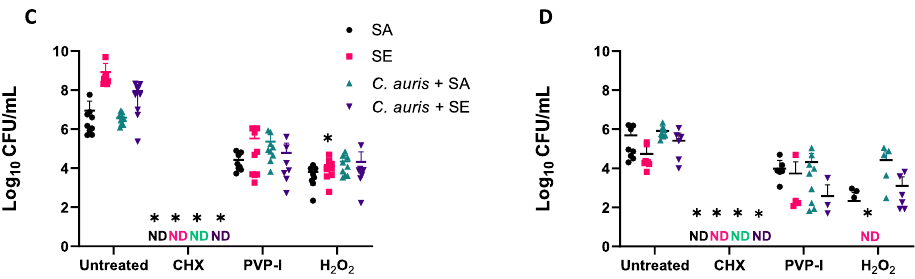
Figure 3. Multi-species biofilms do not provide additional protection against antiseptics. Single